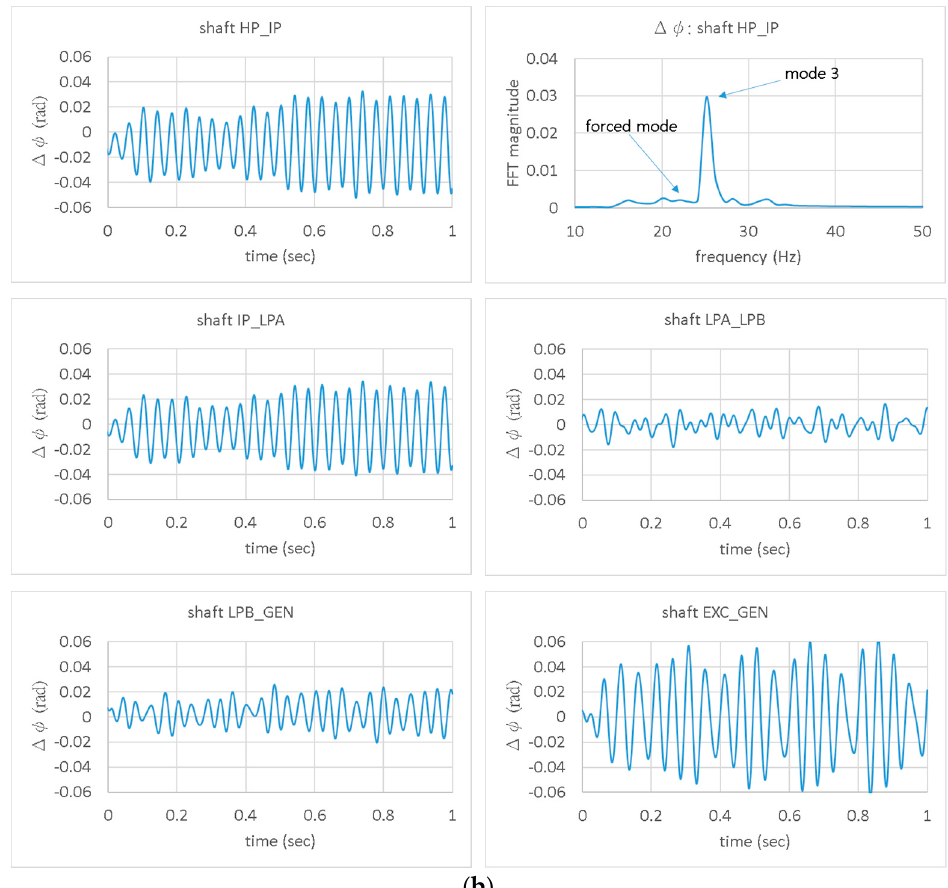
Figure 15. ( a ) Shafts torsional responses for the integration of 400 MW PMSG wind farm. ( b ) Shafts torsional responses for the integration of 600 MW PMSG wind farm.